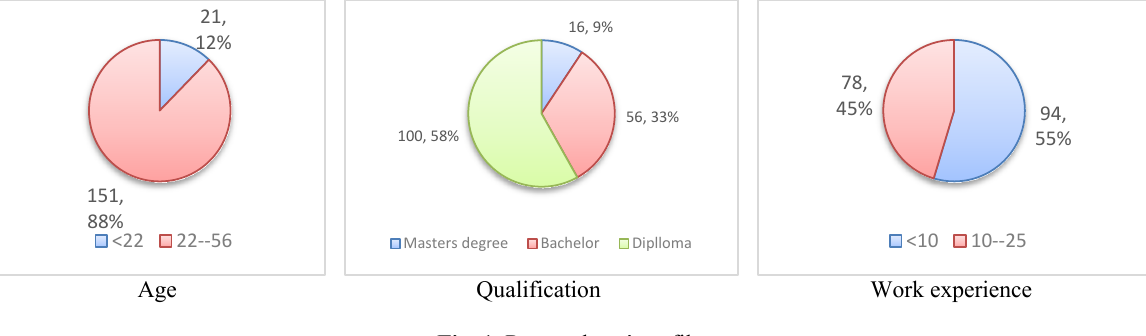
Fig. 1. Respondents’ profile